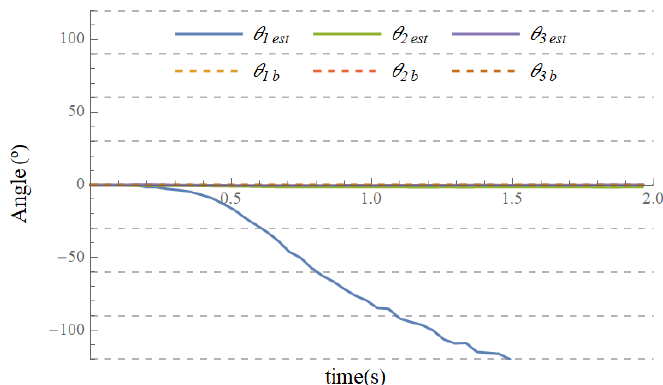
Figure 17. Evolution of the estimates of the joints’ angles during a static test of the joint model using accelerometer measurements.